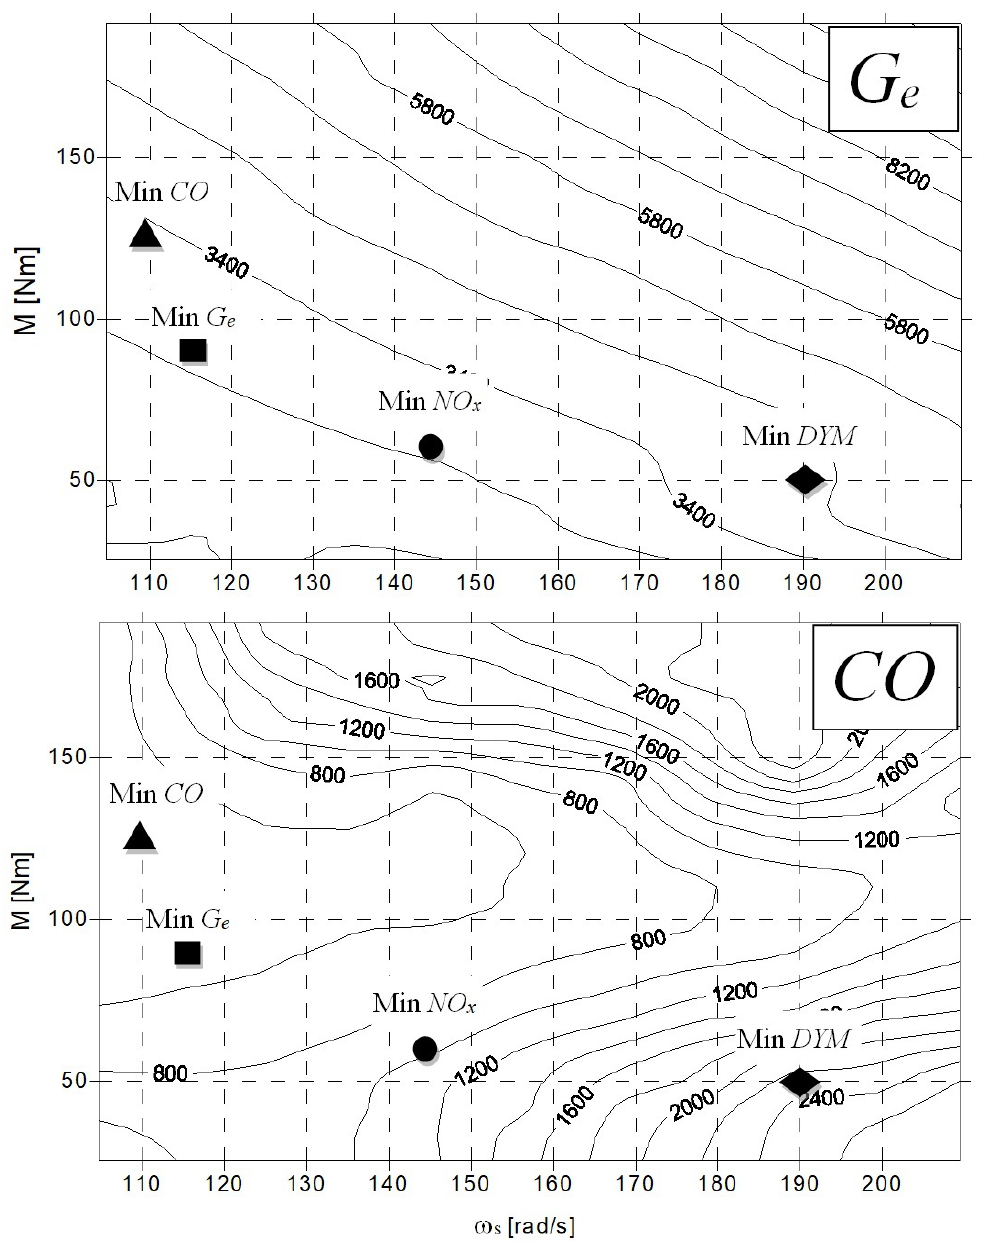
Figure 15. Universal characteristics and optimal points according to particular criteria for load I ( G e , CO